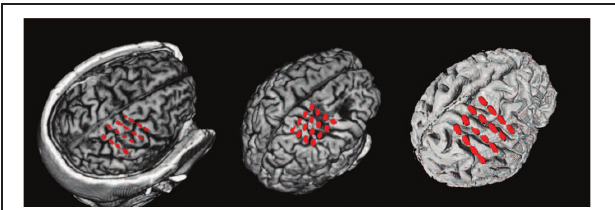
FIGURE 2 | ECoG electrode positions from overlay of MRI and post-surgical CT for the three patients. From left to right: P1–P3.